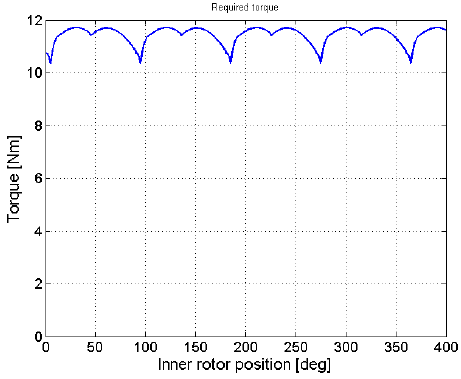
Figure 8. Resistant torque.